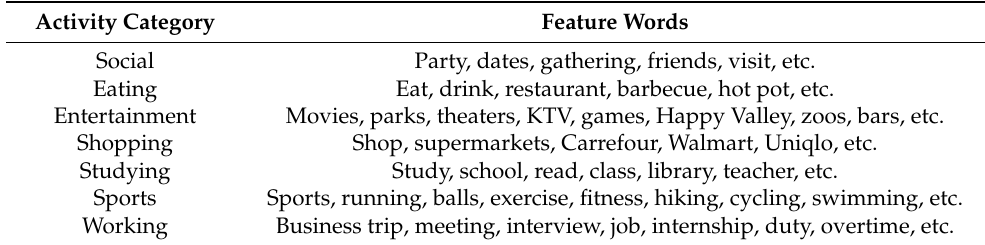
Table 1. The identification of activity categories. Activity